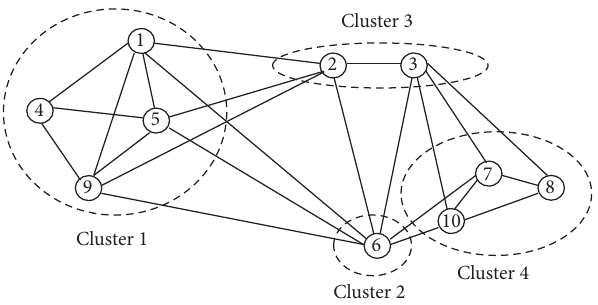
Figure 1: A sample